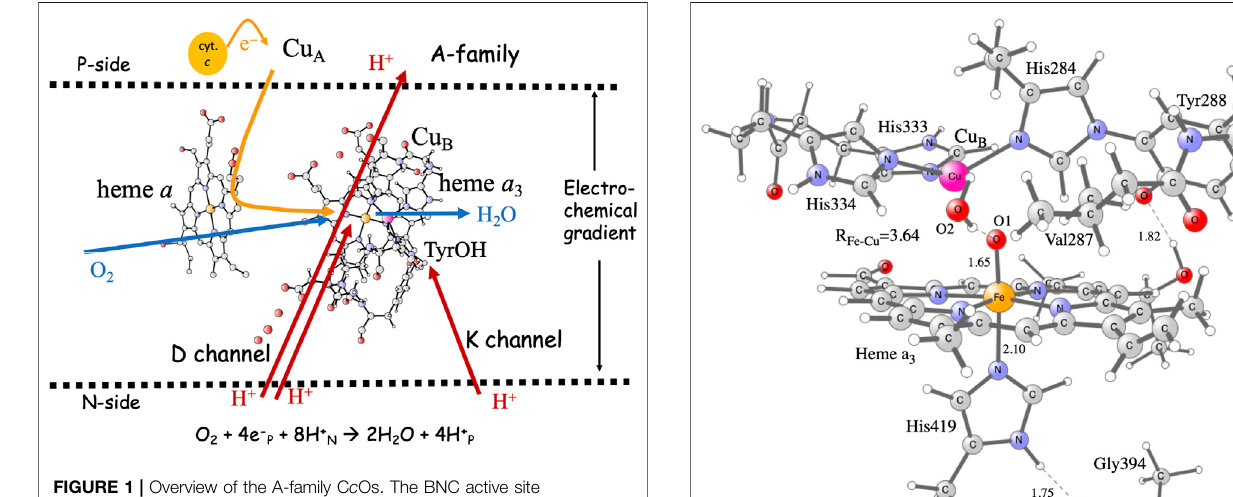
FIGURE 1 | Overview of the A-family C c Os. The BNC active site cofactors: high-spin heme a 3 , Cu B and the cross-linked tyrosine are embedded in the inner mitochondrial or the bacterial membrane. Soluble cytochrome c , the electron transfer cofactors (Cu A and low-spin heme a ), plus proton channels (D and K) from the N-side of the membrane to the BNC are indicated. Electron and proton uptake to the BNC is indicated as arrows, as well as the proton pumping across the entire